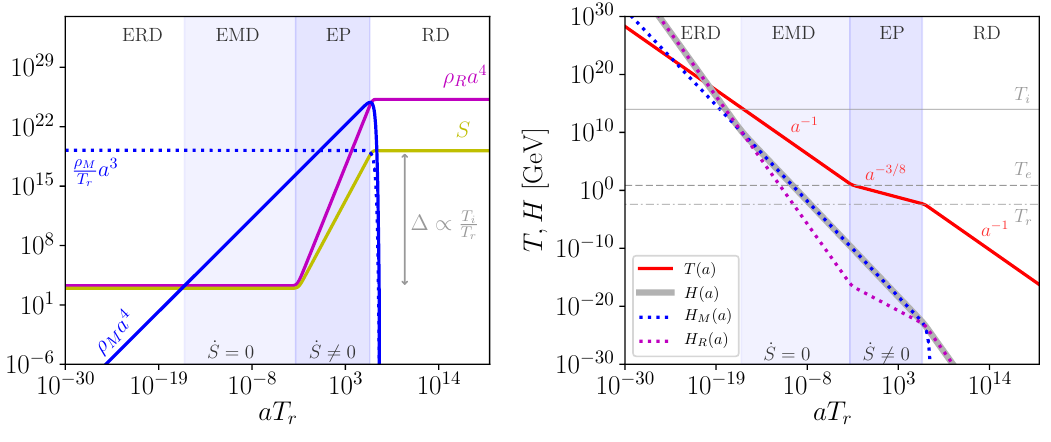
Figure 2 . Left: coupled evolution of the matter (blue) and radiation (magenta) contents (see eq. (3.7)) and of the total entropy (yellow) (see eq. (3.6)). Right: consequent evolution of the temperature (red) and the Hubble rate (grey), along with the contributions of matter and radiation to the expansion (dotted blue and